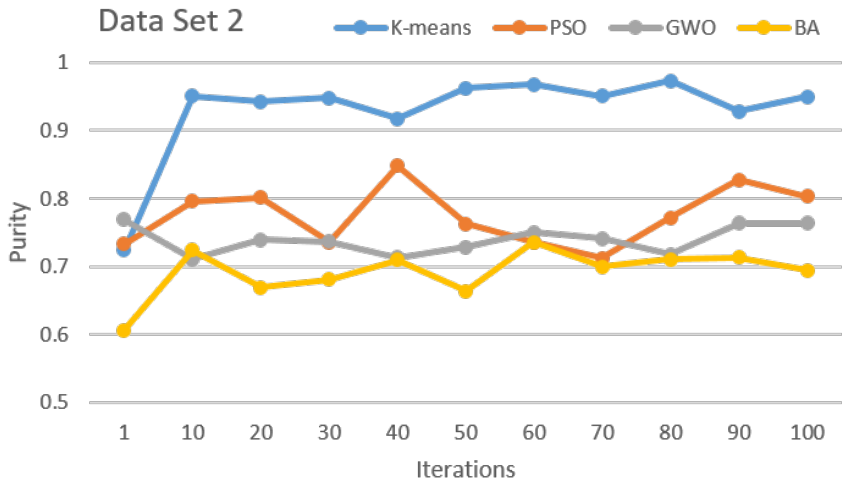
Figure 3. Purity comparison for data set 2.